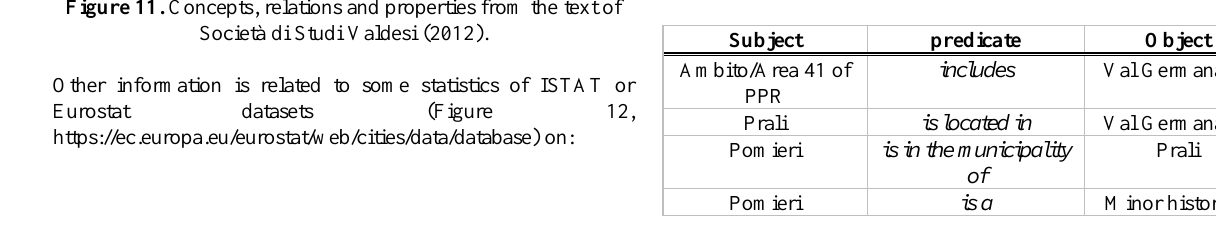
Table 1. Some examples of triples of instances, classes (C) and properties from case study sources and